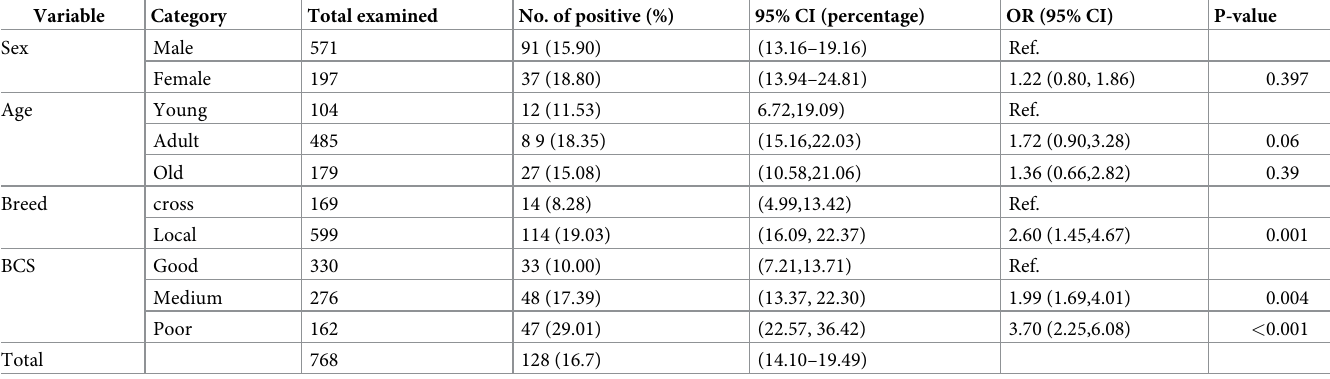
Table 1. Univariable mixed effect logistic regression risk factor analysis with prevalence of S.bovis .